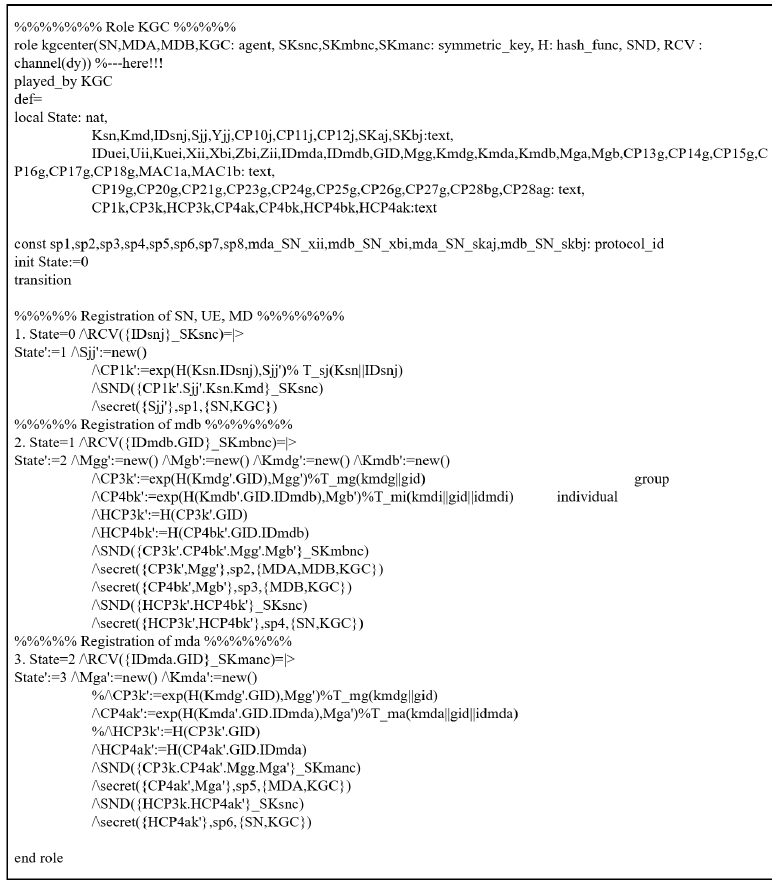
Figure 10. Scenario 2: HLPSL description of KGC role.